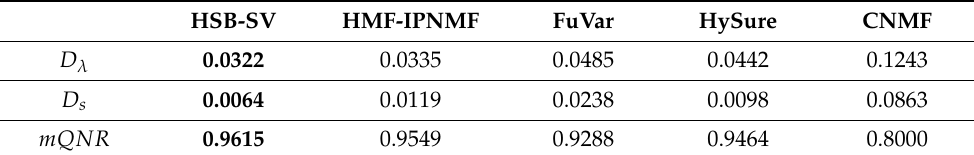
Table 8. Performance criteria for the real